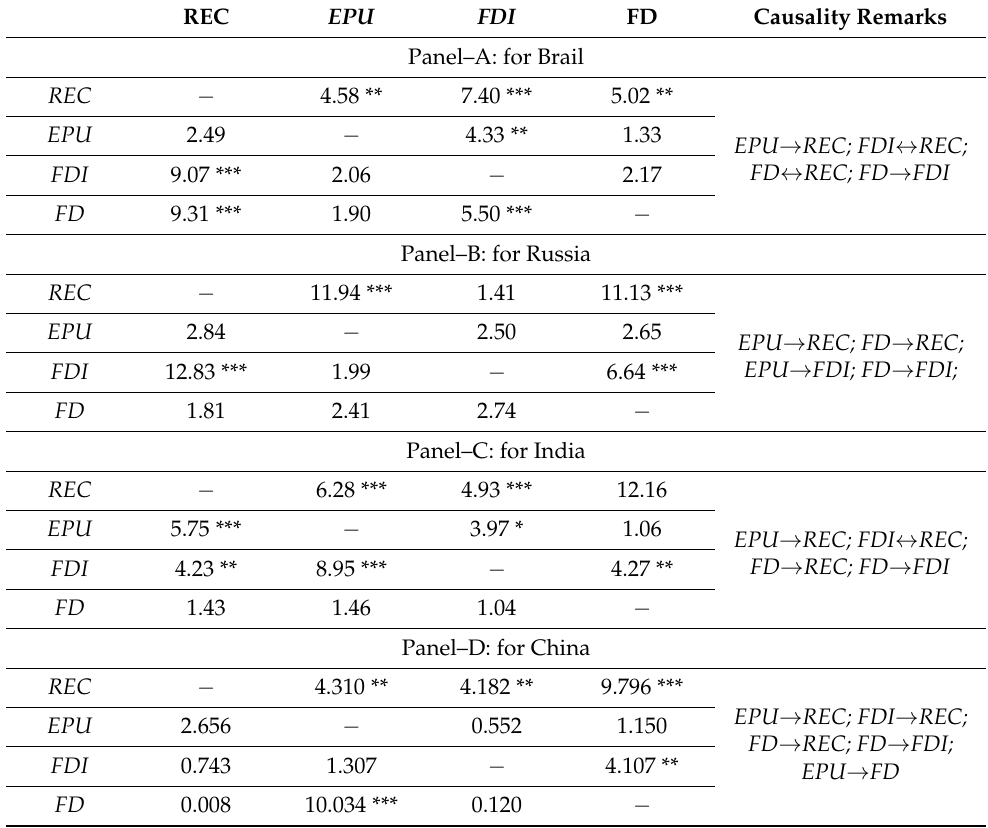
Table 10. Results of toda–Yamamoto causality test (dmax =